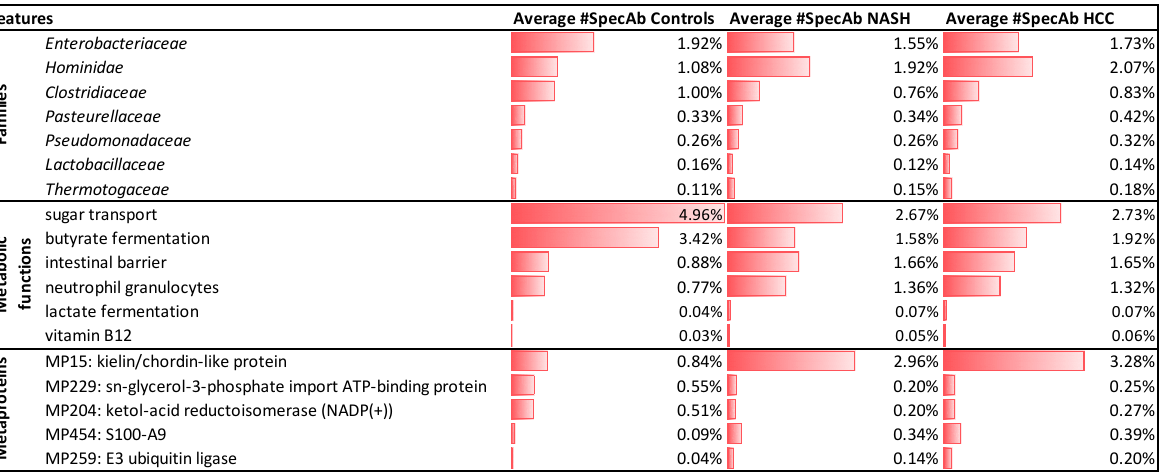
Figure 3. Summary of selected changed features. Significance was evaluated by the Kruskal–Wallis test using a p -value cutoff smaller than 0.01 for families and metabolic functions and smaller than 10 − 5 for metaproteins.